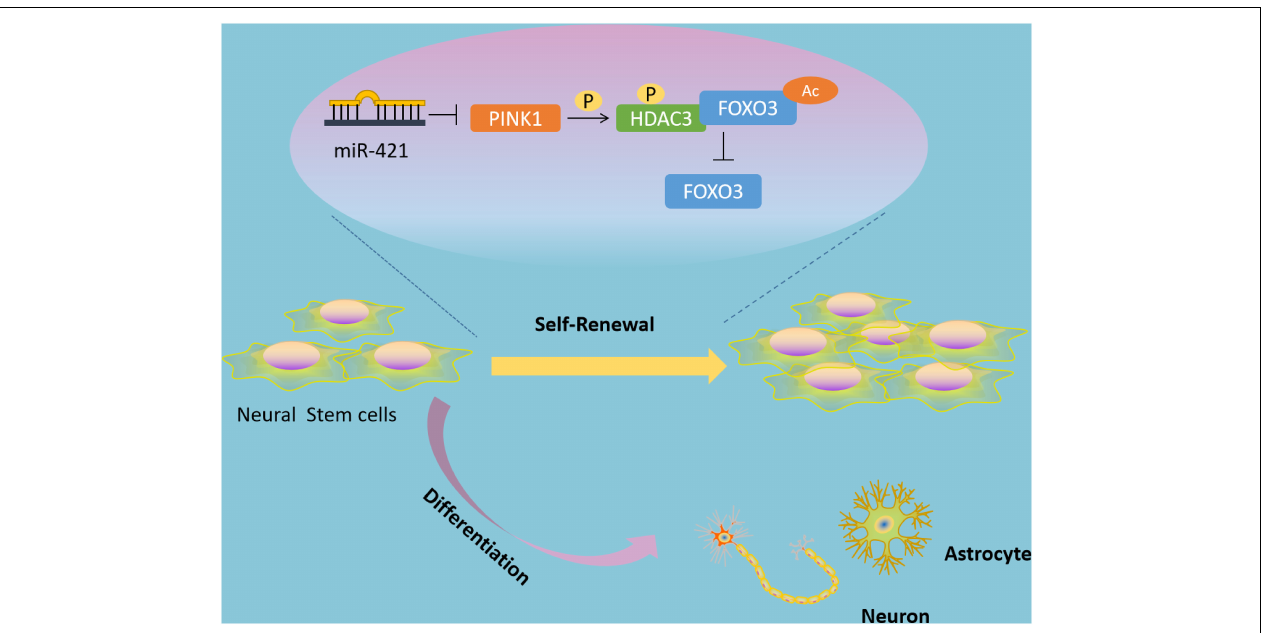
FIGURE 8 | Schematic diagram of the mechanism by which miR-421 modulates the self-renewal of NSCs through the PINK1/HDAC3/FOXO3 axis. miR-421 binds to PINK1 3 (cid:48) -UTR to restrict its transcription expression, further downregulating HDAC3 phosphorylation, and affecting the binding between HDAC3 and FOXO3. This results in upregulation of FOXO3 acetylation and subsequent increase in the expression of FOXO3, thereby enhancing the self-renewal of NSC. Therefore, miR-421 enhances the NSC self-renewal via the PINK1/HDAC3/FOXO3